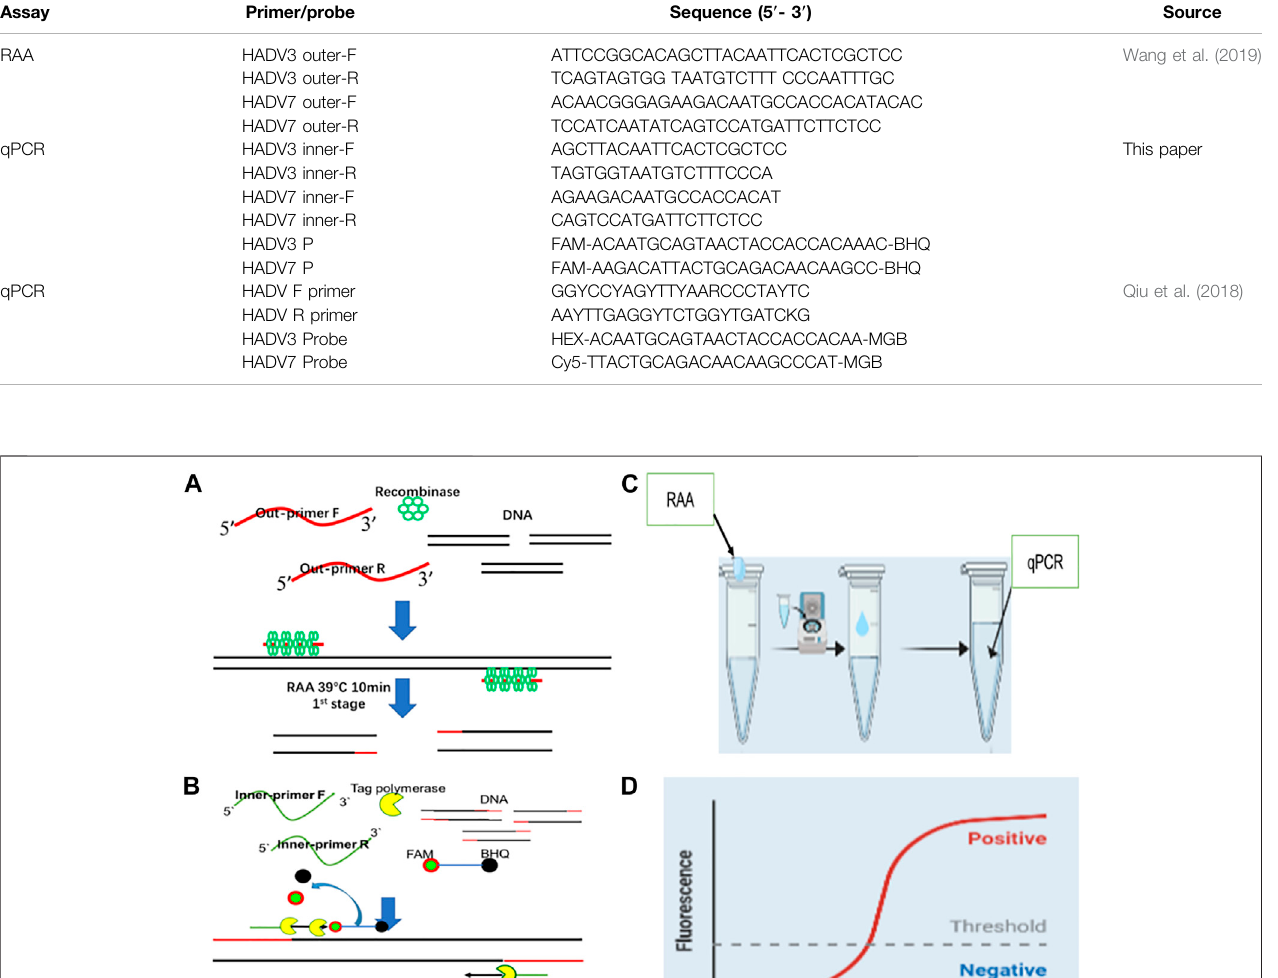
Frontiers in Bioengineering and Biotechnology |